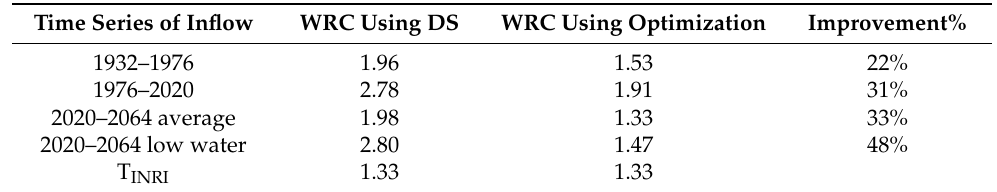
Table 2. INRI indicator values for the eight performed WRCs.